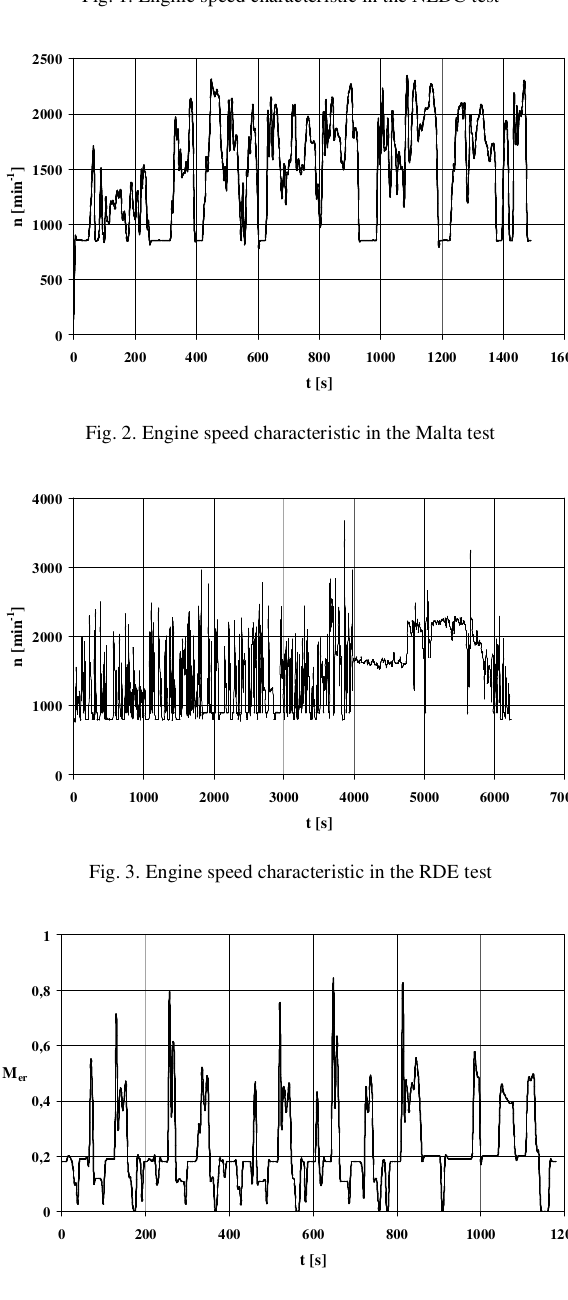
Fig. 1. Engine speed characteristic in the NEDC test